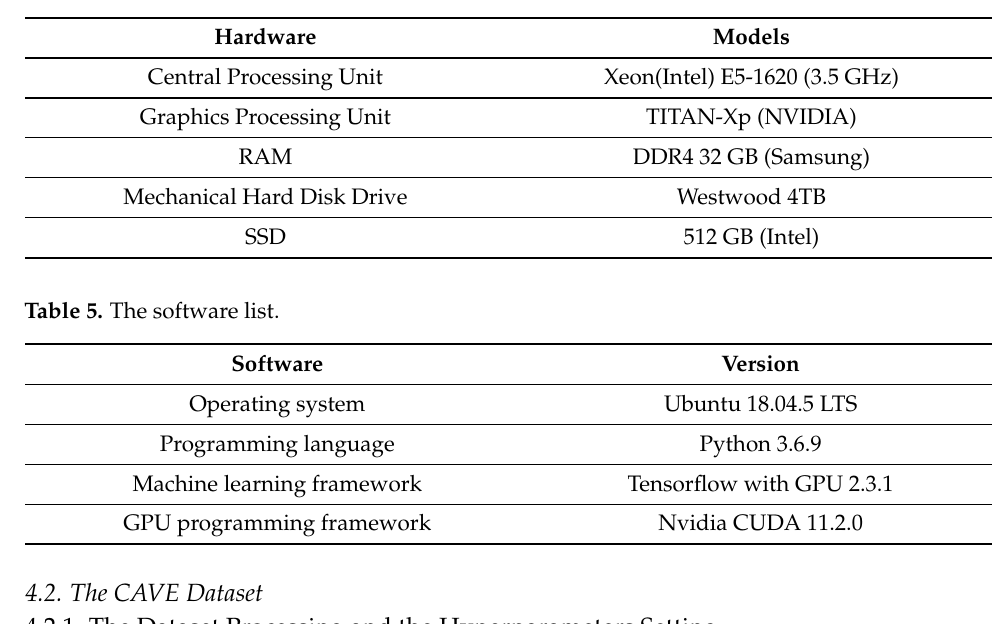
Table 4. The hardware list.